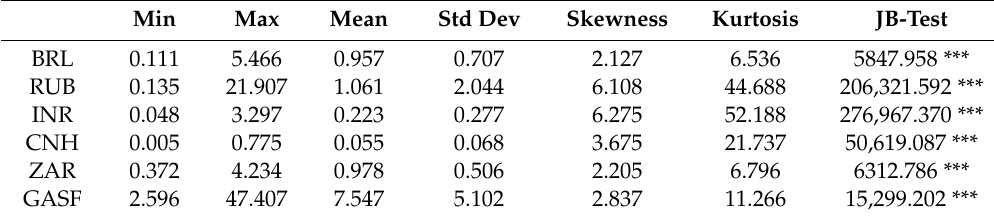
Table 3. Summary statistics for volatilities of daily returns.